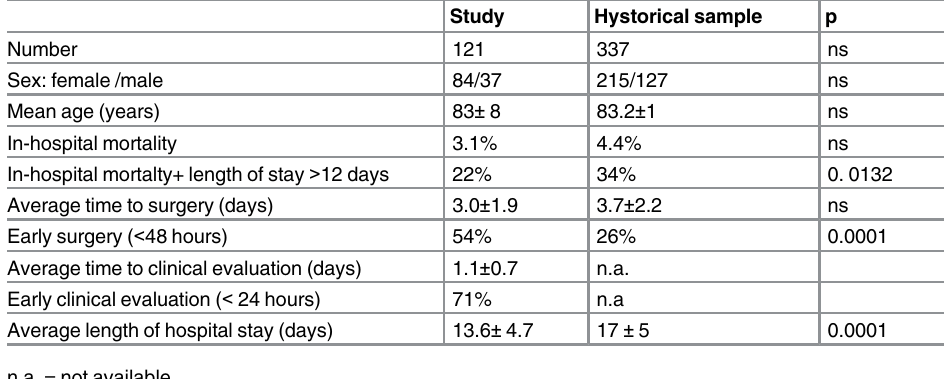
Table 3. Comparison of patients under study with historical sample.